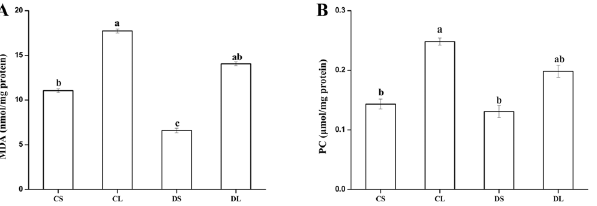
Fig 5. Effects of DMG-Na on mitochondrial MDA (A) and PC (B) concentrations in LPS-injected mice liver. Values are mean ± SEMs (n = 10). Mean of a variable without a common letter differ, P < 0.05. Malondialdehyde (MDA); Protein carbonyl. (PC). CS, gastric intubation in mice with 0 mg DMG-Na/0.3 ml sterile saline solution for 28 days and intraperitoneal injection with 100 μ g/kg body weight of sterile saline solution at 29 day; CL, gastric intubation in mice with 0 mg DMG-Na/0.3 ml sterile saline solution for 28 days and intraperitoneal injection with 100 μ g/kg body weight of LPS at 29 day; DS, gastric intubation in mice with 12 mg DMG-Na/0.3 ml sterile saline solution for 28 days and intraperitoneal injection with 100 μ g/kg body weight of sterile saline solution at 29 day; DL, gastric intubation in mice with 12 mg DMG-Na/0.3 ml sterile saline solution for 28 days and intraperitoneal injection with 100 μ g/kg body weight of LPS at 29